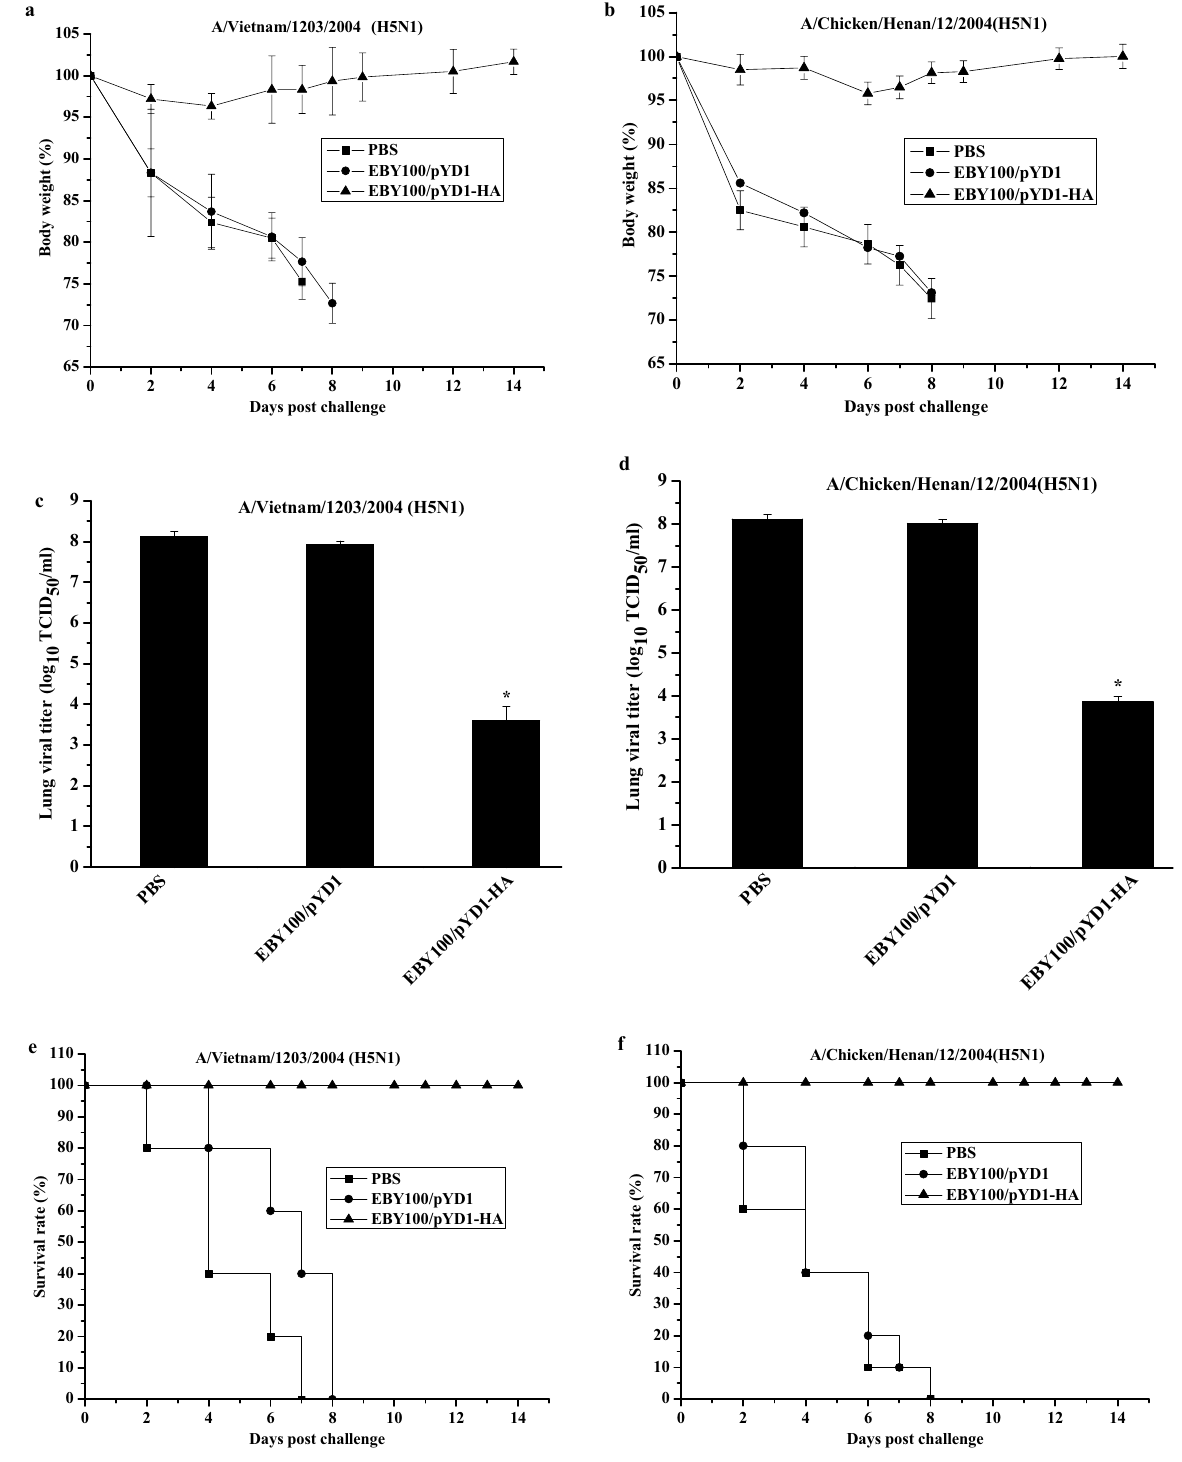
Figure 4. Immune protection efficacy of EBY/pYD1-HA against different H5N1 viruses. Chickens were intranasally challenged with a lethal dose (25 μL of 10 4 EID 50 ) of H5N1 virus. ( a ) Weight change as a percentage after A/Vietnam/1203/2004 (H5N1) (clade 1) challenge. ( b ) Weight change as a percentage after A/Chicken/ Henan/12/2004 (H5N1) (clade 8) challenge. ( c ) Lung viral titers at day 3 post A/Vietnam/1203/2004 (H5N1) (clade 1) challenge. ( d ) Lung viral titers at day 3 after A/Chicken/Henan/12/2004(H5N1) (clade 8) challenge. (n = 3 chickens per group). ( e ) Survival rates after A/Vietnam/1203/2004 (H5N1) (clade 1) challenge. ( f ) Survival rates after A/Chicken/Henan/12/2004(H5N1) (clade 8) challenge. (n = 10 per group). The weight change data are presented as the means ± SDs. Asterisks indicate significant difference compared with the PBS- and EBY100/pYD1 controls. (* p ˂